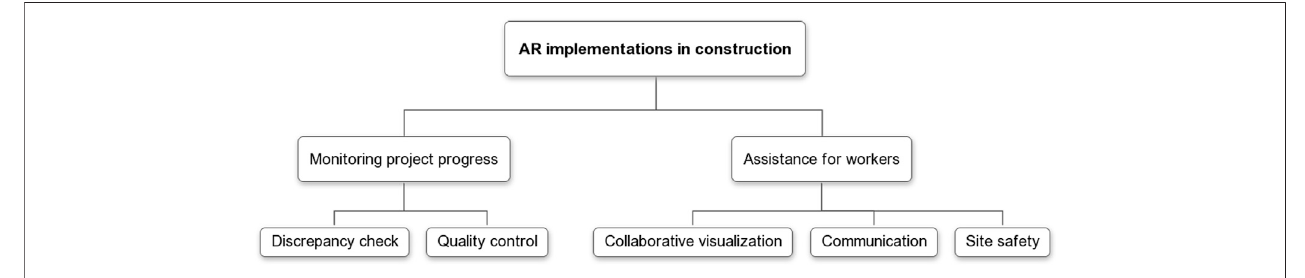
FIGURE 5 | Different research areas of AR implementations in